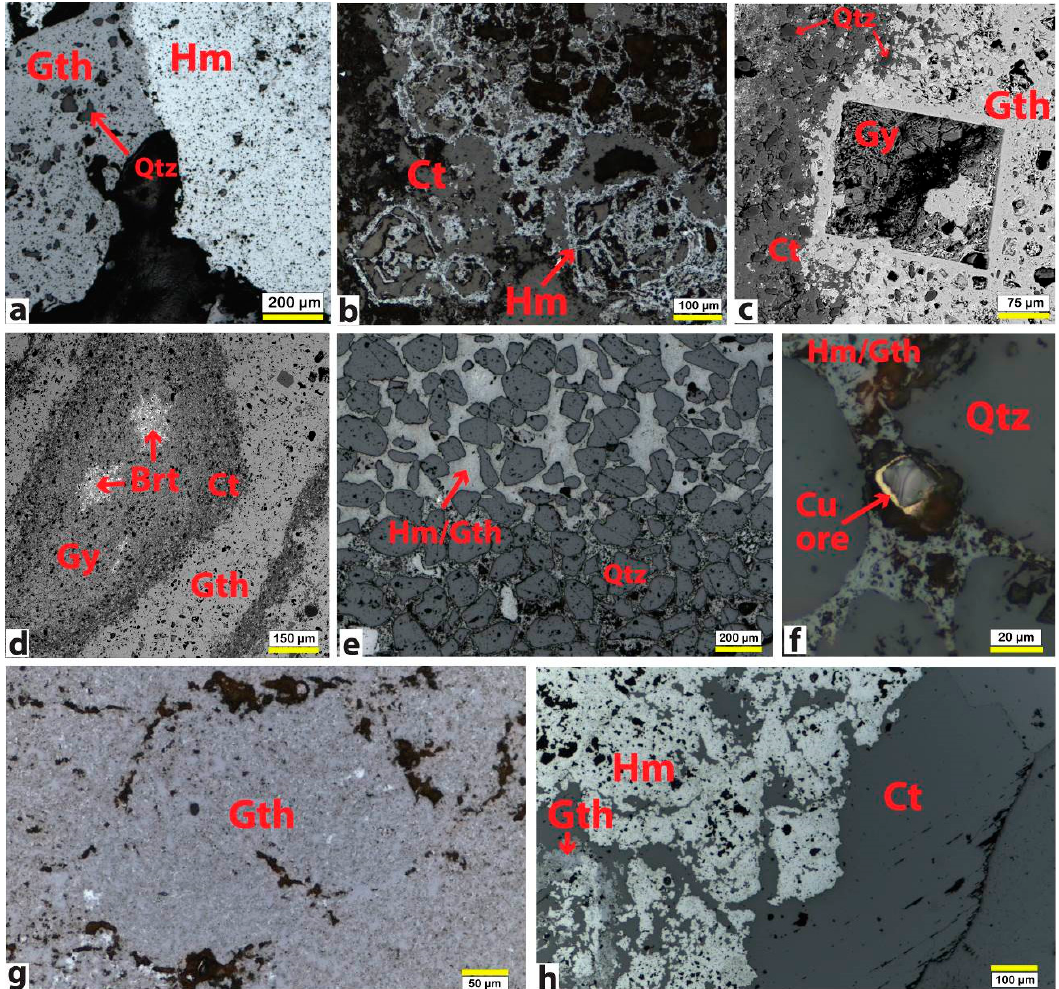
Figure 3. Microstructures of assayed ores: ( a ) OM. Negev-6. Intergrowth of goethite (Gth) and hematite (Hm). Goethite-rich part contains significant amount of quartz (Qt); ( b ) OM. Negev-9. Pseudomorphs of hematite after calcite (Ct); ( c ) SEM Backscattered Electron Imaging (BEI). Negev-2. To the right: Crystal of gypsum (Gy) in goethite matrix. To the left: The area composed of calcite and quartz; ( d ) SEM-BEI. Negev-2. Lens enriched with calcite, gypsum, and barite (Brt, white core of the lens); ( e ) OM. Arabah-2. Banded structure of the ore. Upper layer consists of quartz present in the matrix of hematite and goethite. ( f ) OM. Arabah-2. Copper ore (Cu ore) mineral of the ore; ( g ) OM. Ajloun-3. Ore dominated by goethite; ( h ) OM. Ajloun-2. Ore dominated by hematite, with minor presence of goethite, in the matrix of calcite.